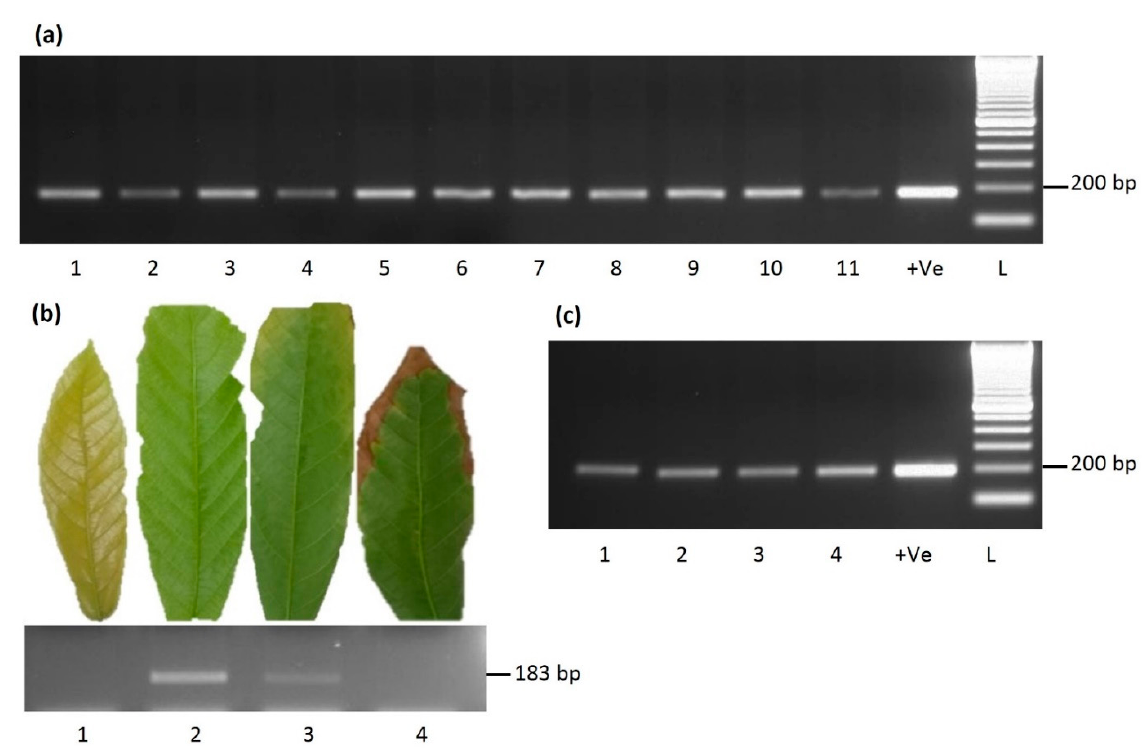
Figure 3. PCR based detection of cacao yellow vein-banding virus (CYVBV) and cacao mild mosaic virus (CaMMV) in cocoa. ( a ) A 183 bp fragment of RT-RNase H region of CYVBV amplified from cocoa accessions GU 144/C (1), GU 219/F (2), GU 265/P (3), GU 341/H (4), IMC 85 (5), JA 10/12 [POU] (6), ICS 60 (7), ICS 95 (8), NAP 25 (9), PA 156 [PER] (10) and TRD 45 (11), and the same locus amplified from four leaves (1–4) from three consecutive flushes of accession IMC 85 ( b ). Sampled leaves are shown in the upper panel and the gel image of the PCR is shown in the lower panel. ( c ) A 193 bp fragment of RT-RNase H region of CaMMV amplified from cocoa accessions GEBP 584/A-F [ADI] (1), PNG 138 (2), SCA 12 (3) and WA 40 [DR] (4). ICS 27 was included as positive control (+Ve) in both assays.